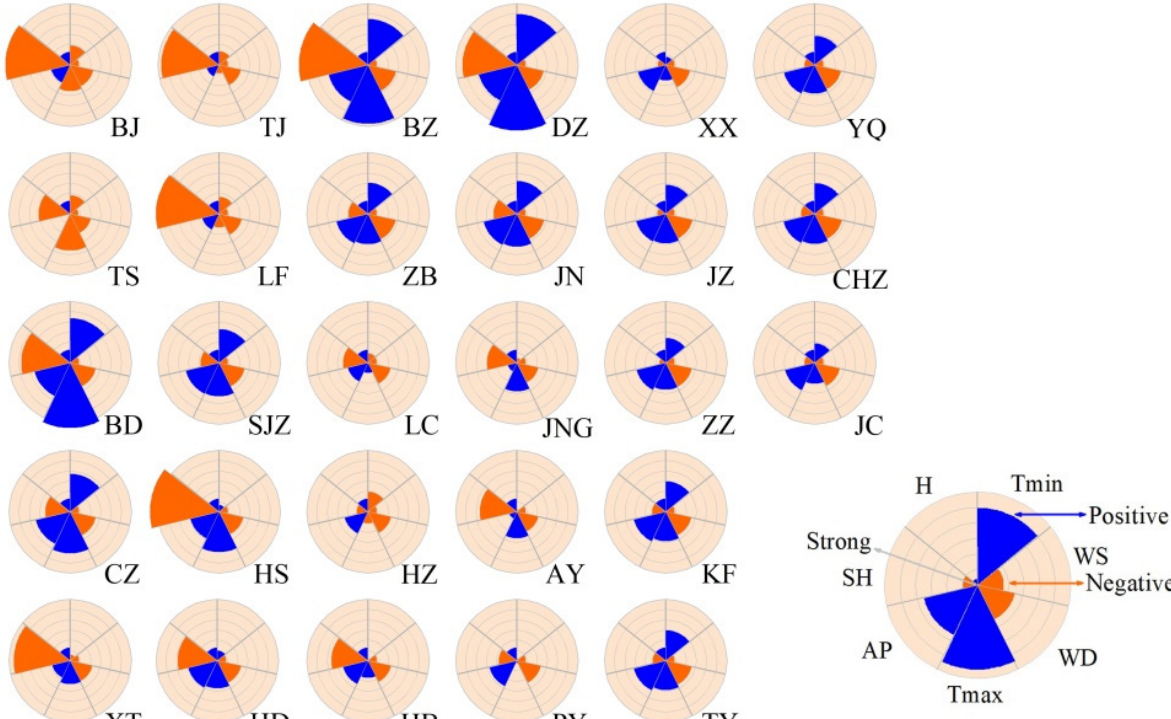
Figure 6. The influence characteristics of meteorological factors for each city based on regression coefficients derived from geographically weighted regression at the annual scale. Blue and orange indicate positive and negative spatial correlations, respectively, between mean PM 2.5 concentration and meteorological variables. Annuli from the center outward represent the magnitude of the regression coefficient, from lowest to highest: SH , sunshine hours; T max , daily maximum temperature; T min , daily minimum temperature; AP , average atmospheric pressure; H , average relative humidity; WS maximum wind speed; WD , wind direction; BJ, Beijing; TJ, Tianjin; SJZ, Shijiazhuang; TS, Tangshan; LF, Langfang; BD, Baoding; CZ, Cangzhou; HS, Hengshui; XT, Xingtai; HD, Handan; BZ, Binzhou; DZ, Dezhou; ZB, Zibo; JN, Jinan; LC, Liaocheng; JNG, Jining; HZ, Heze; AY, Anyang; HB, Hebi; PY, Puyang; XX, Xinxiang; JZ, Jiaozou; ZZ, Zhengzhou; KF, Kaifeng; TY, Taiyuan; YQ, Yangquan; CHZ, Changzhi; JC, Jincheng.